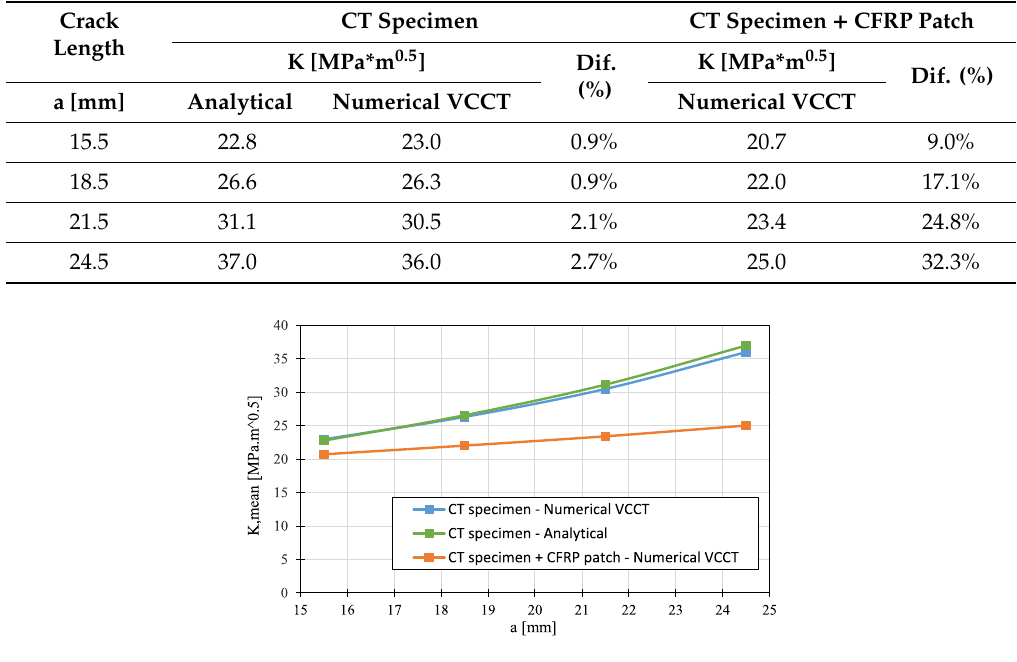
Figure 11. Comparison of final stress intensity factors.